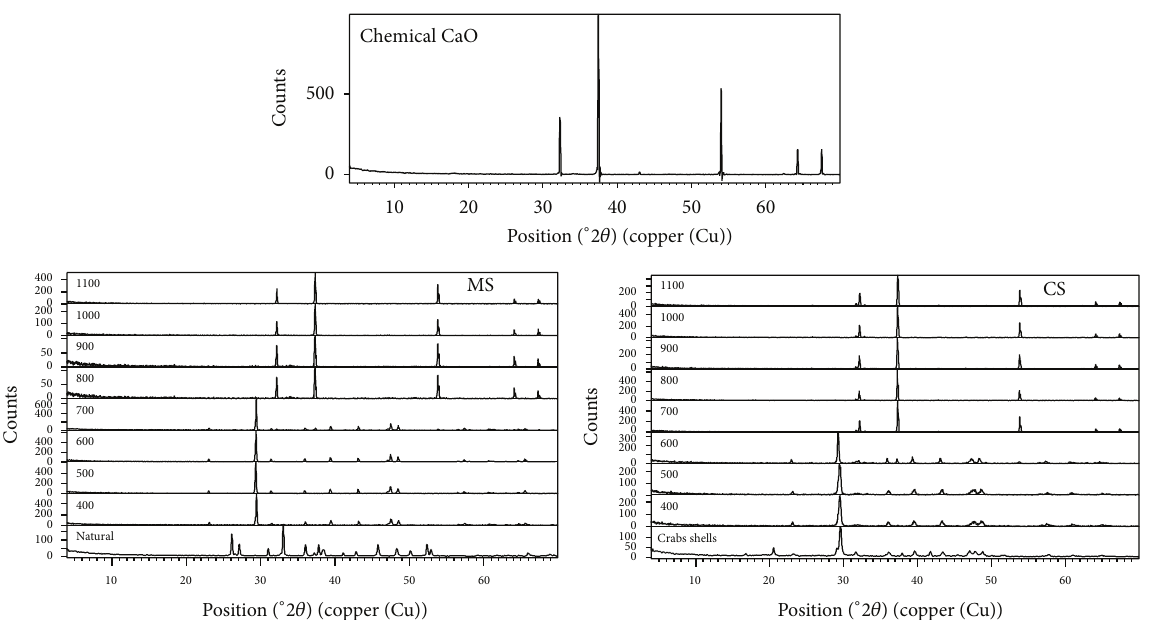
Figure 2: XRD patterns during calcination at different